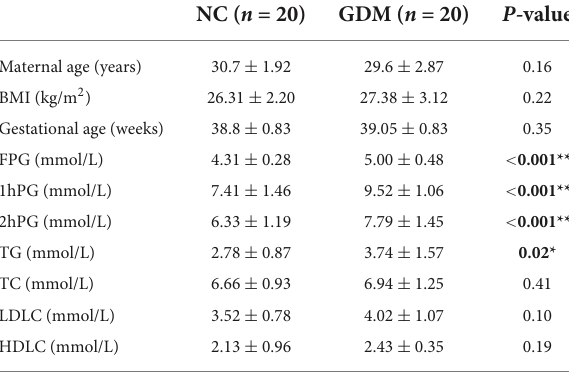
TABLE 1 Clinical characteristics of pregnant women with or without